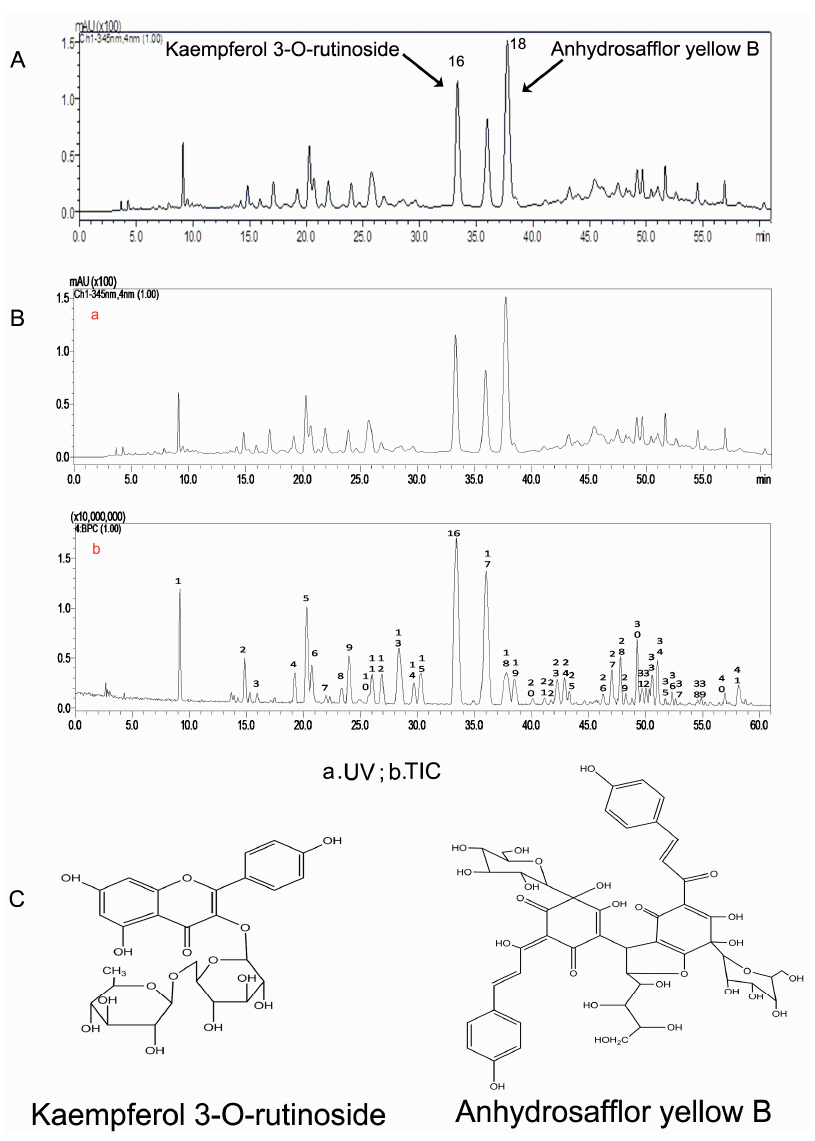
Figure 1. ( A ) The HPLC chromatogram at 345 nm of SAFE; ( B ) The negative ion base peak chromatogram of SAFE; ( C ) Chemical structures of kaempferol 3- O -rutinoside and anhydrosafflor yellow B.